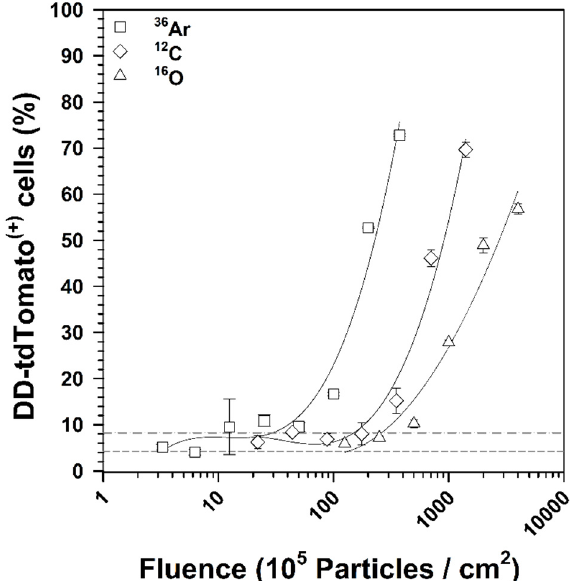
Figure 3. NF- κ B activation in response to different heavy ion fluences. HEK-pNF κ B-DD-tdTomato-C8 cells were fixed 18 h after exposure to 36 Ar (LET 272 keV/µm), 12 C (LET 73 keV/µm), and 16 O (LET 51 keV/µm) ions. DD-tdTomato expression was determined by measuring the fluorescence intensity using flow cytometric analysis. The percentage of DD-tdTomato positive cells (DD-tdTomato (+)) was determined using histograms of the red fluorescence (see Supplementary Figure S1) and is shown as mean ± SD ( n = 2). The short dash line indicates the percentage of DD-tdTomato(+) cells in mock-irradiated samples and the dash–dot line indicates the double of this percentage, which was defined as the threshold for NF- κ B activation.